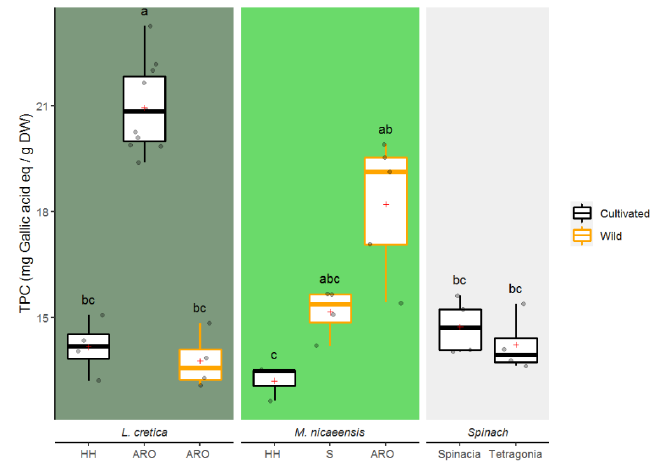
Figure 3. Total phenolic content (TPC) of leaves of two Malvaceae species and two spinach species. Different lowercase letters indicate significant differences between types of green leaves ( p < 0.05). Species names and abbreviations of locations are given in the lower line. HH = Havat Hanoi, ARO = research site at the Agricultural Research Organization; S = agricultural area near Sandala village, North Israel. Box plot color indicates “Cultivated” in an agricultural field, or “Wild”, grown wildly at field margins or feral fields. Median and average are indicated as a horizontal line within the box plot and red cross, respectively, and gray dots denote results of single analyses.